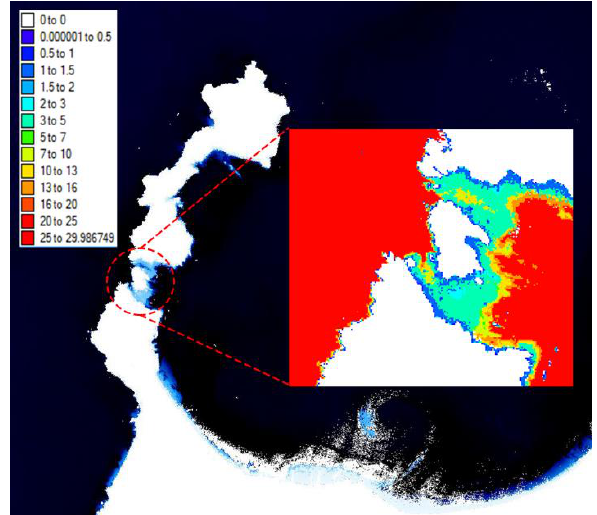
Figure 7. Depth images calculated on the scene acquired in